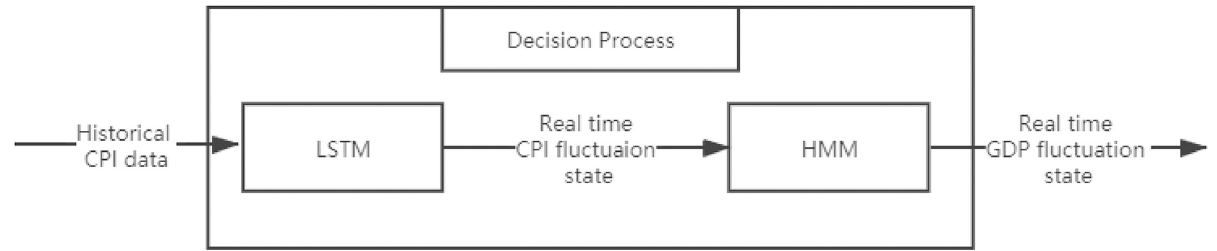
Fig 3. The whole decision process of Long Short Term Memory Recurrent Neural Network and Hidden Markov Model (LSTM-HMM) with quarterly univariate-input that introduces LSTM to forecast CPI fluctuation states.